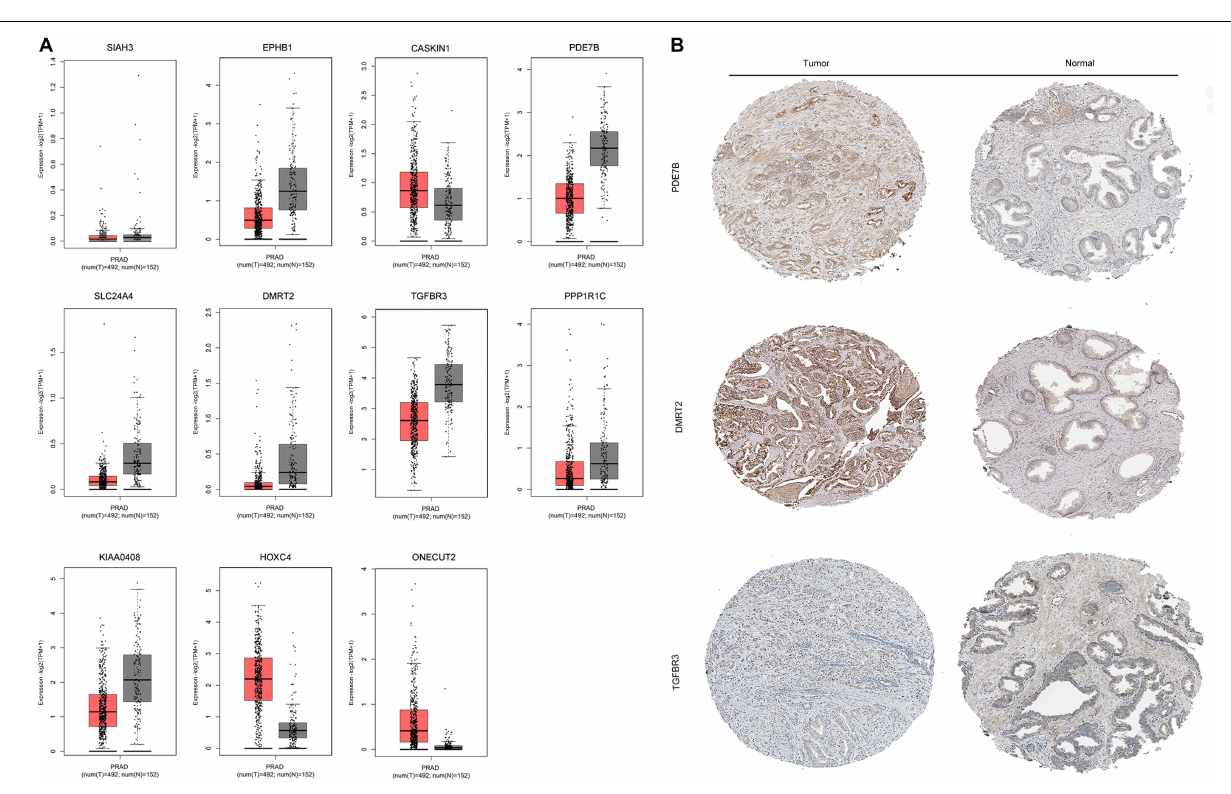
Frontiers in Genetics |